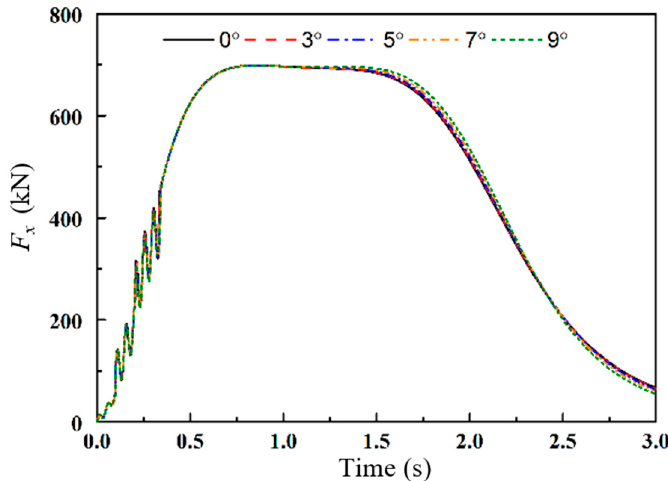
Figure 17. Longitudinal acceleration–time.